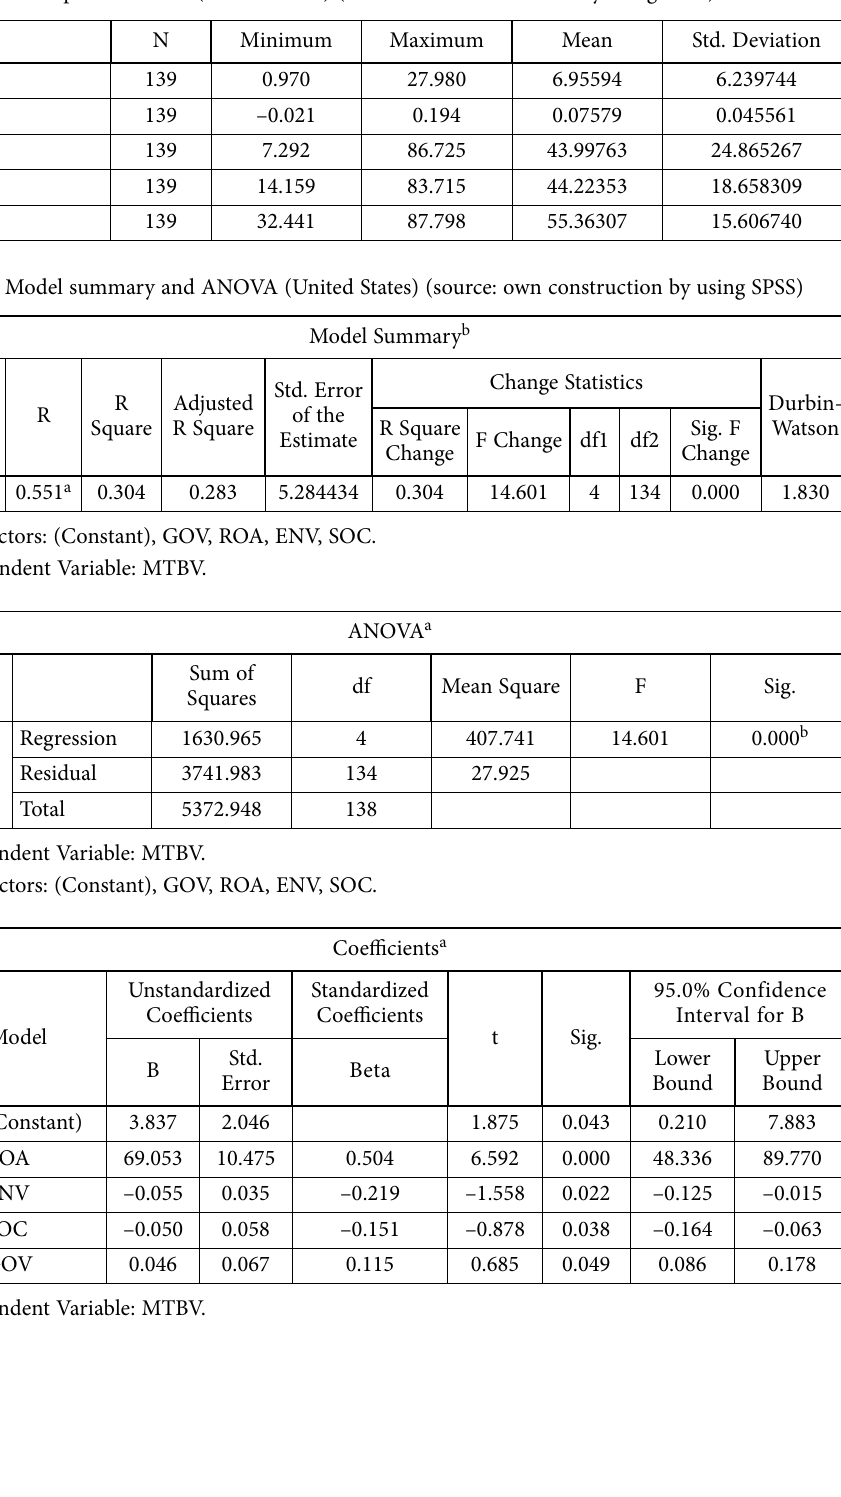
Table 7. Descriptive statistics (United States) (source: own construction by using SPSS)